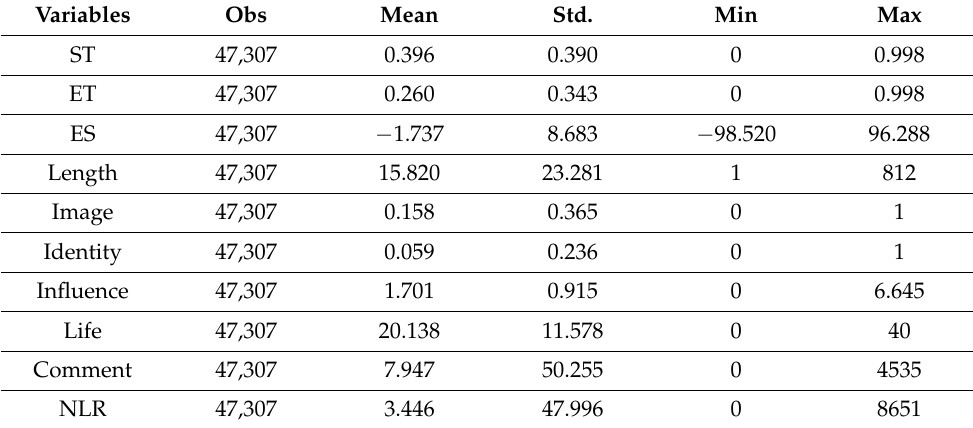
Table 2. Descriptive statistics of